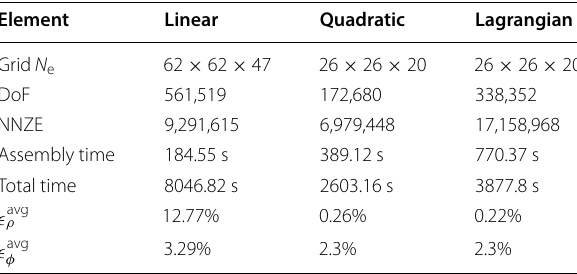
Times are shown in seconds, and the memory is presented in terms of the number of elements N e , the number of unknowns (DoF) and the number of non‑ zero entries for the global array NNZE. Average errors are shown for resistivity ǫ avg ρ , and for the phase ǫ avg φ